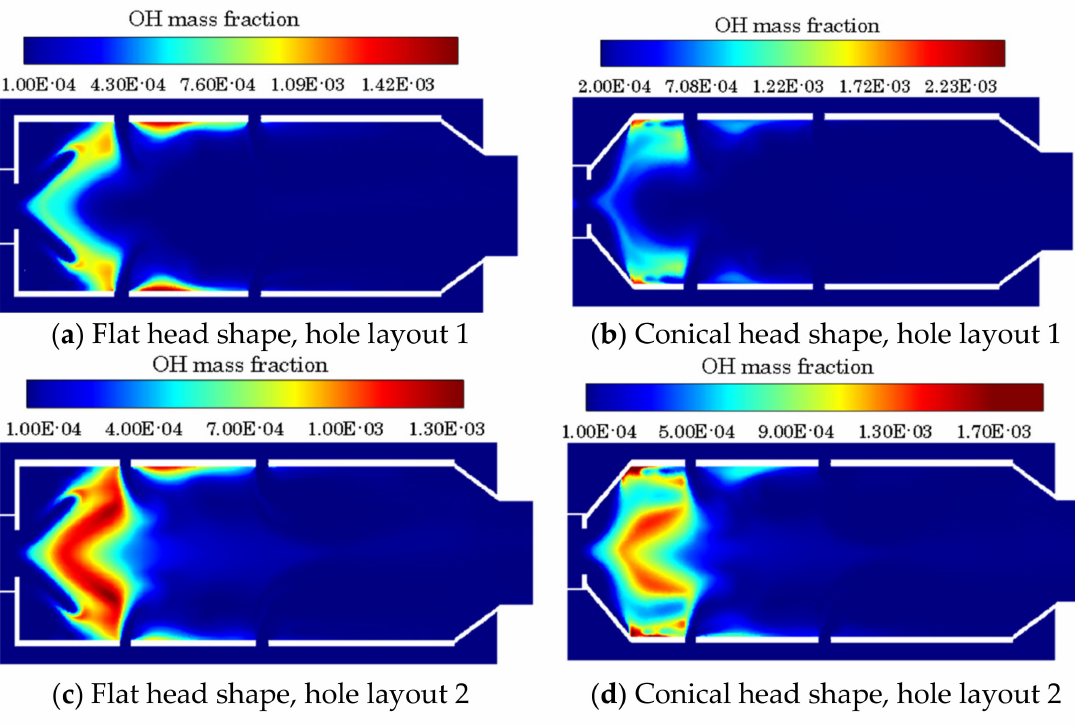
Figure 7. OH mass contours for various dome